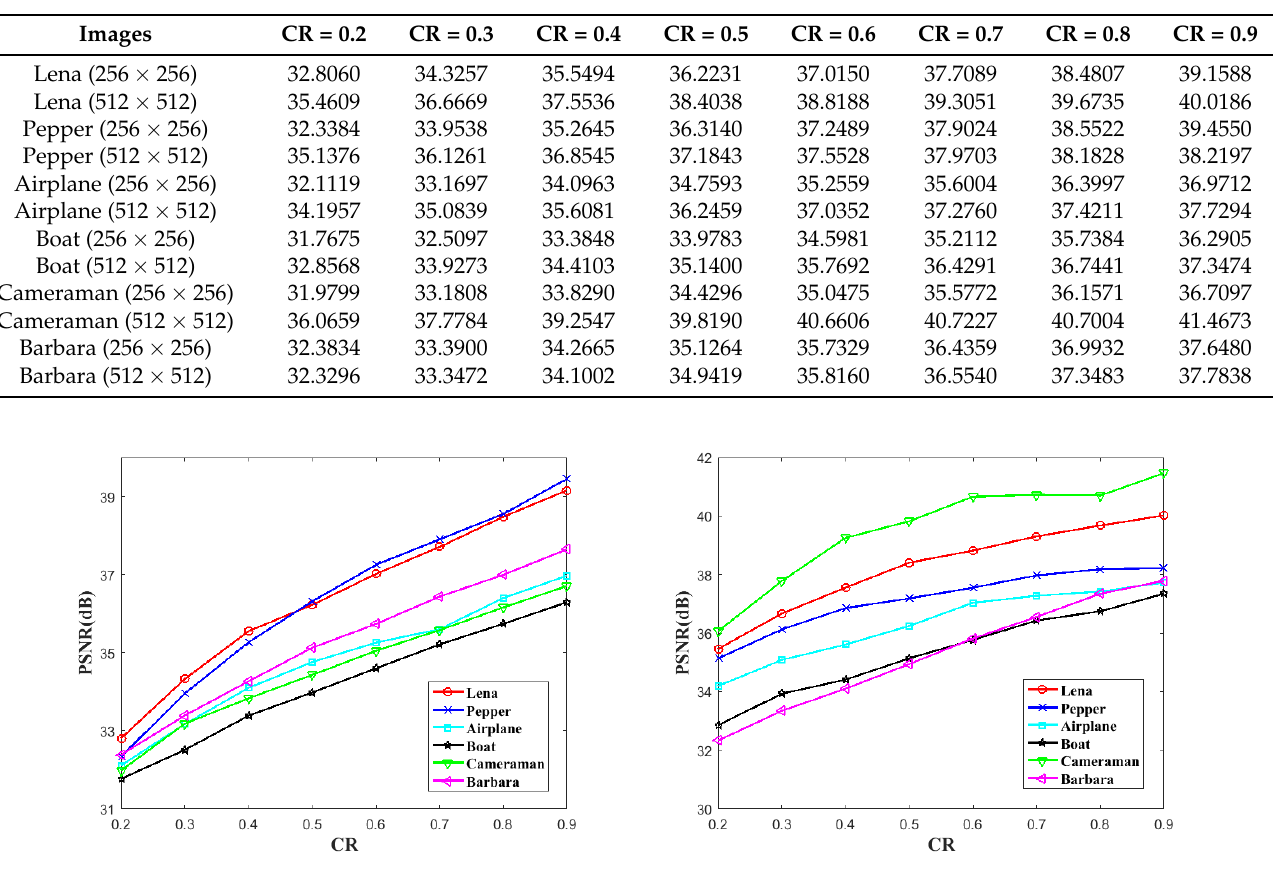
Table 1. The peak signal to noise ratio (PSNR) test results.